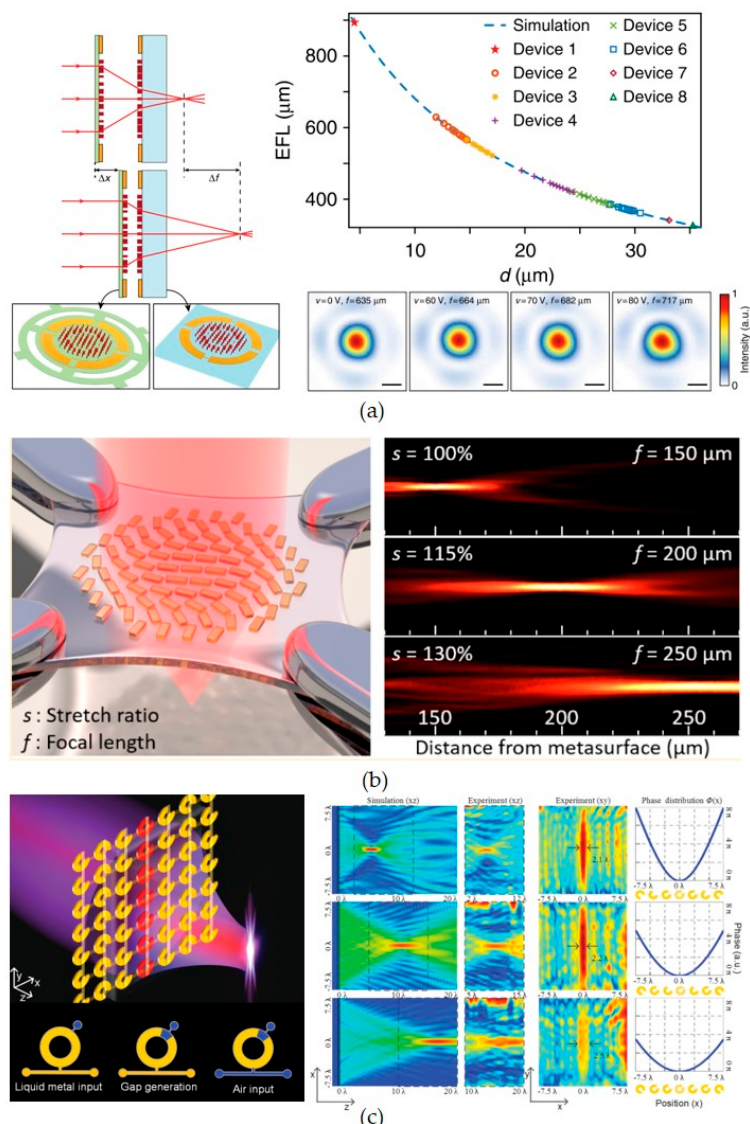
Figure 5. Tunable lens based on MEMS and microfluidic metasurfaces. ( a ) Tunable lens based on MEMS metasurface doublets; ( b ) tunable lens based on flexible substrate; ( c ) microfluidic